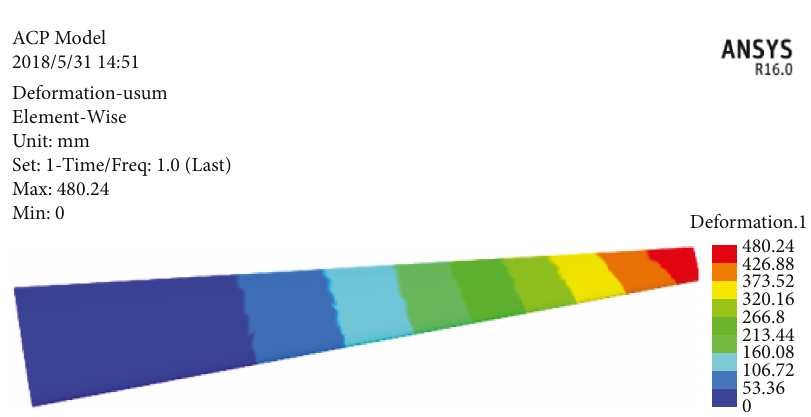
Figure 53: Deformation cloud diagram with the layer ratio being